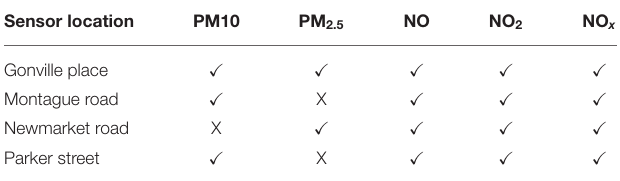
TABLE 1 | Pollutants monitored in Cambridge city. Sensor location